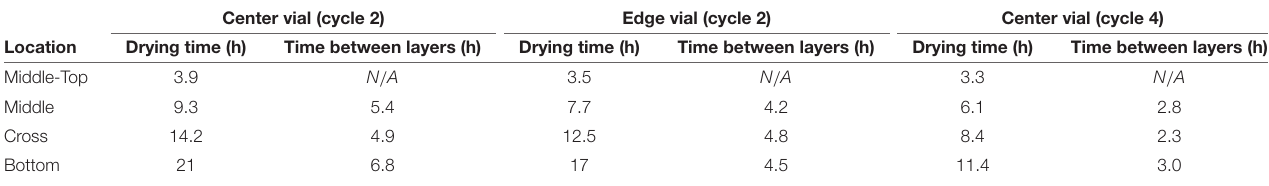
TABLE 2 | Primary drying time measured by multi-point wireless sensor. Center vial (cycle 2)